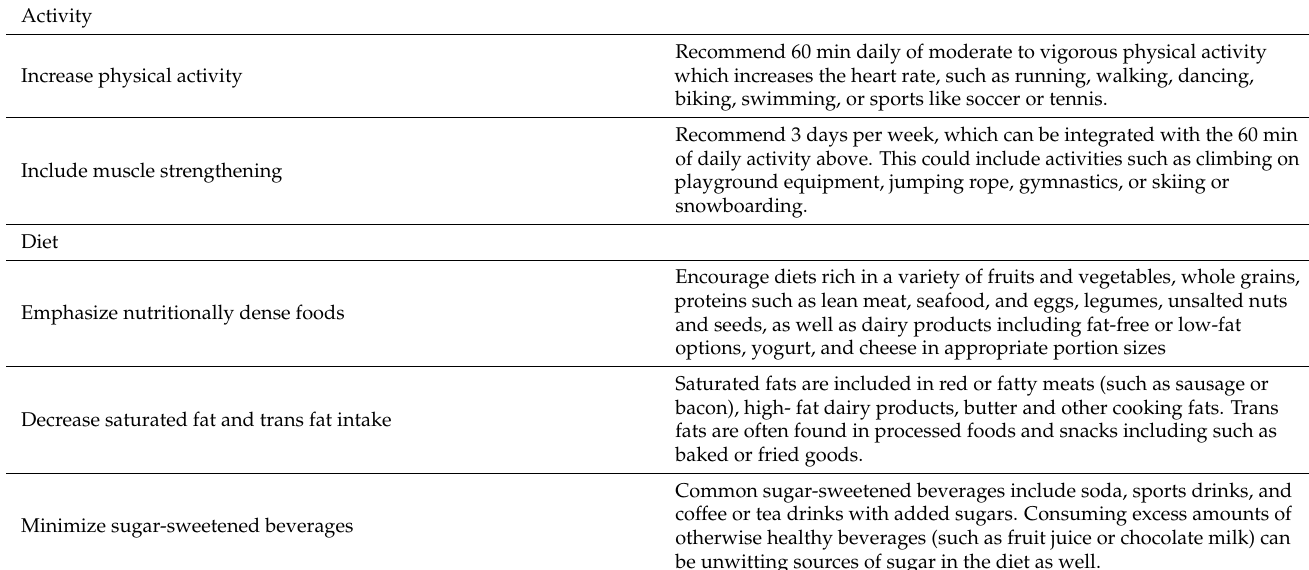
Table 3. Lifestyle modifications for Pediatric Dyslipidemias [14–16]. Adapted from the